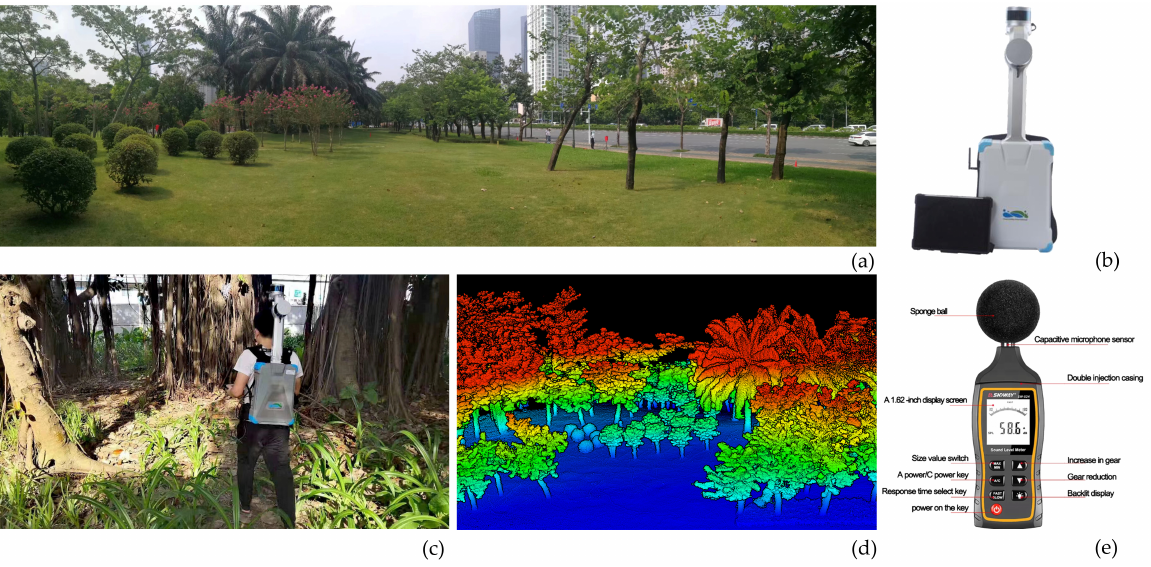
Figure 4. Quadrat measurement: ( a ) photo of the quadrat, ( b ) LiBackpack D50, ( c ) data are collected by using a LiDAR knapsack, ( d ) the collected quadrat point cloud data, ( e ) noise meter.